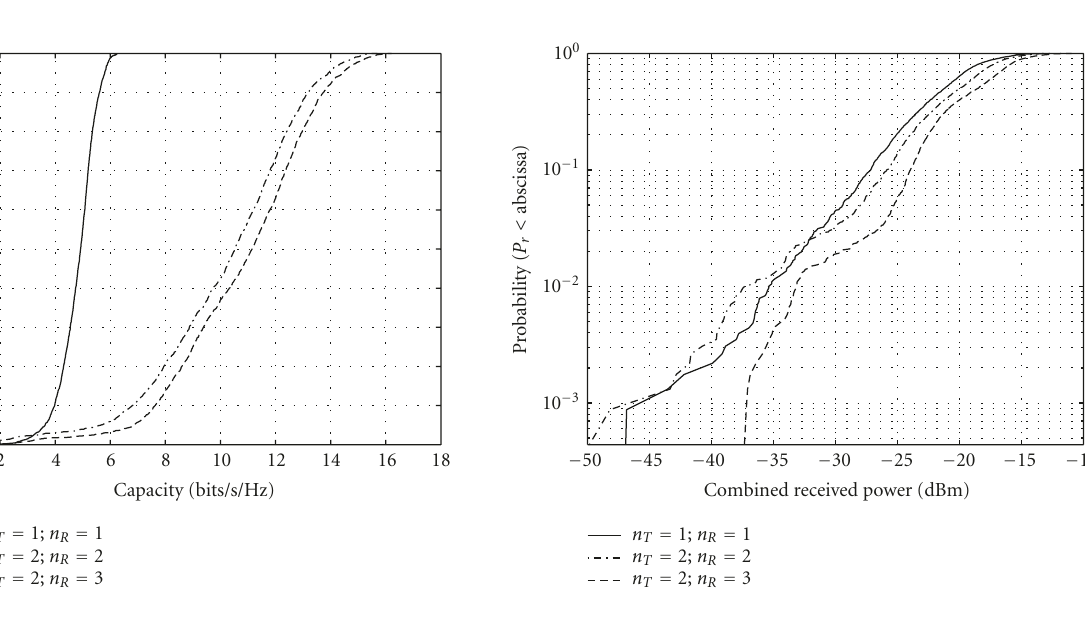
Figure 10: CDF of the received power (Scenario 1).